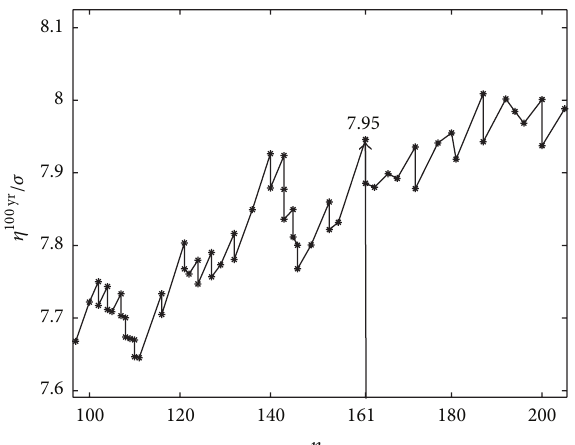
Figure 7: The point estimate 𝜂 100 yr of the 100-year return level based on 13 years hourly data as a function of the number 𝑛 of data points above threshold. 𝜎 = 6.01 m/s.